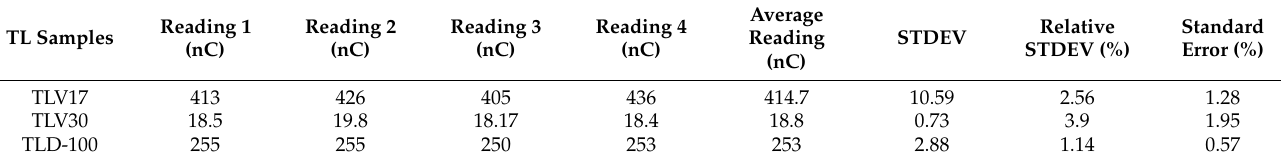
Table 6. The reproducibility of the TL